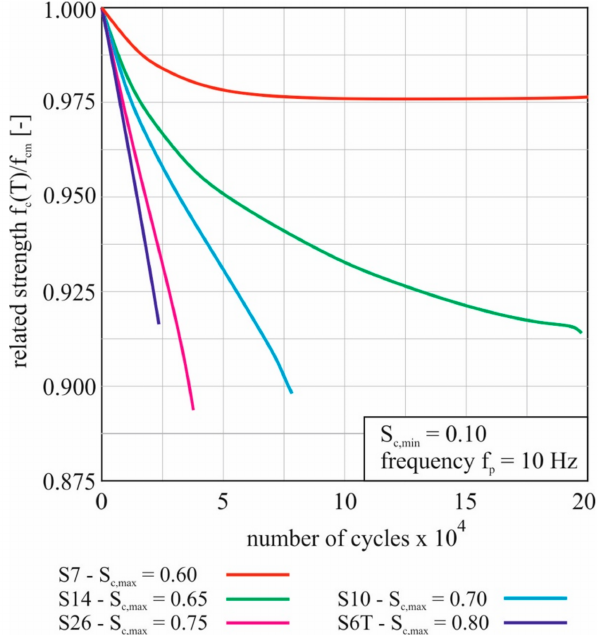
Figure 4. Decreasing relative concrete compressive strengths in fatigue tests dependent on the occurring heating of the